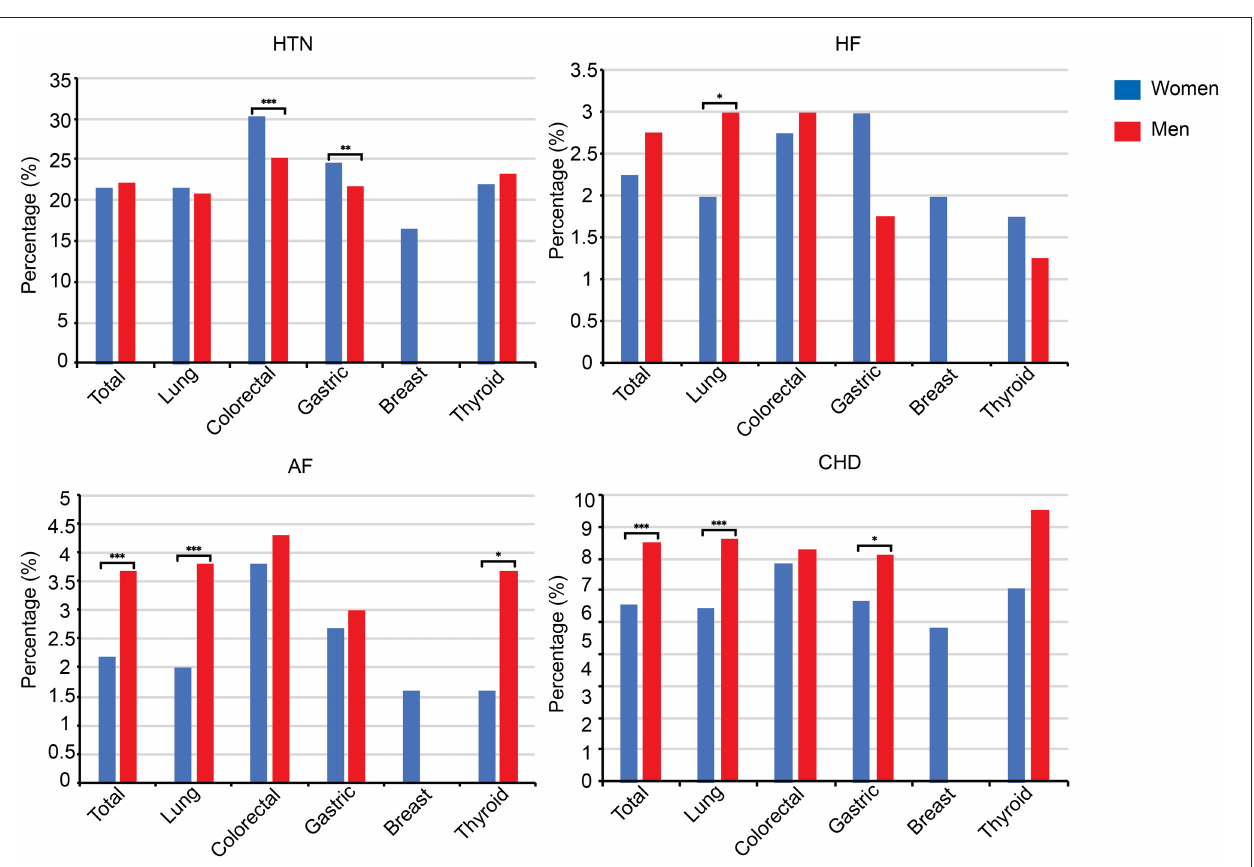
FIGURE 3 | Comparison of CVD comorbidities between men and women according to cancer categories. HTN, hypertension; HF, heart failure; AF, atrial fibrillation; CHD, coronary heart disease; * P < 0.05, *** P < 0.001.